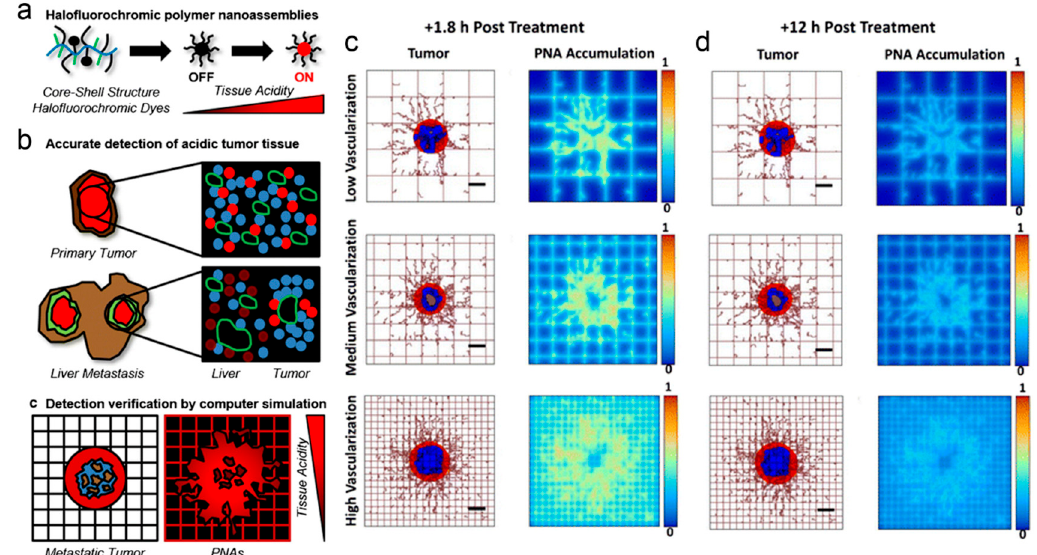
Figure 9. ( a , b ) Illustrative description of the strategy used for detecting liver metastatic colorectal tumors using halofluorochromic polymer nanoassemblies (PNAs) and computational simulations. ( c , d ) Simulation results reflecting the distribution of the nanoparticles in metastatic tumors at ( c ) 1.8 h and ( d ) 12 h, after systemic injection of the nanoparticles for three different degrees of vascularization. Red refers to viable tumor tissue, blue reflects enclosing hypoxic tissue, and brown reflects necrotic regions. The rectangular grid represents the capillary network, displaying irregular sprouts, which simulate the angiogenesis effect and the growth of blood vessel. Reprinted with permission from [147]. Copyright Springer Nature, 2017.